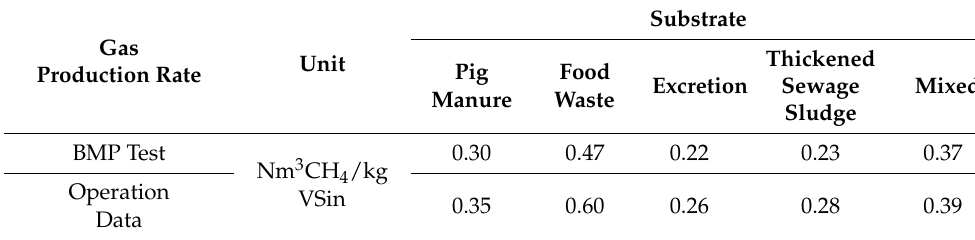
Table 8. Methane production rate.